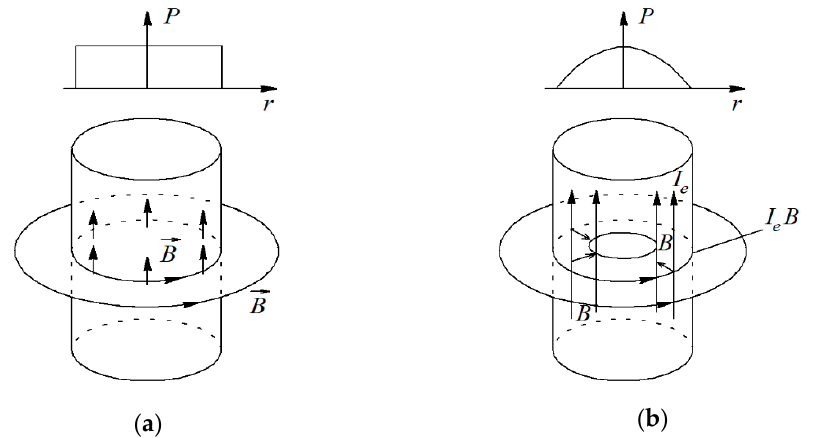
Figure 7. Pinch effect in the sintered powder volume: ( a ) Uniform current distribution along cross-sectional area; ( b ) Conductor with the surface current.